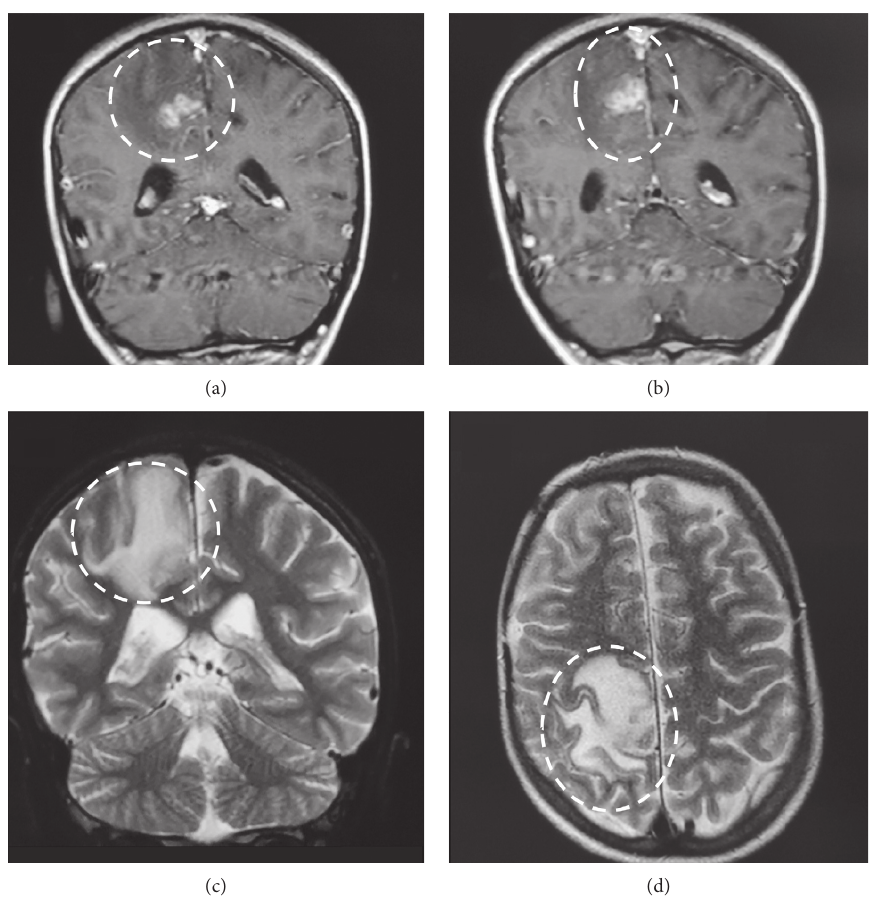
Figure 2: Brain magnetic resonance imaging (MRI): 2.2 × 2.0cm ring-enhancing parasagittal lesion in the right parietal